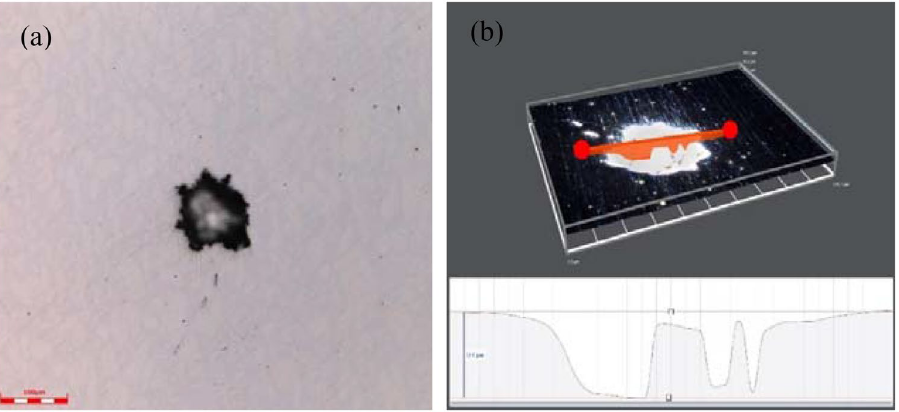
Figure 10. Pitting morphology of 2205 DSS ( a ) Pitting micro morphology, ( b ) Pitting